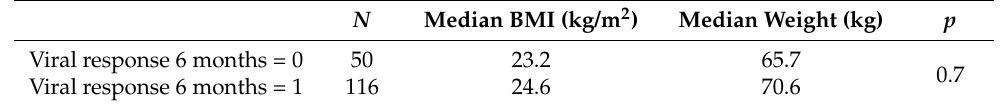
Table 4. Characterization of the lot in terms of BMI and weight.